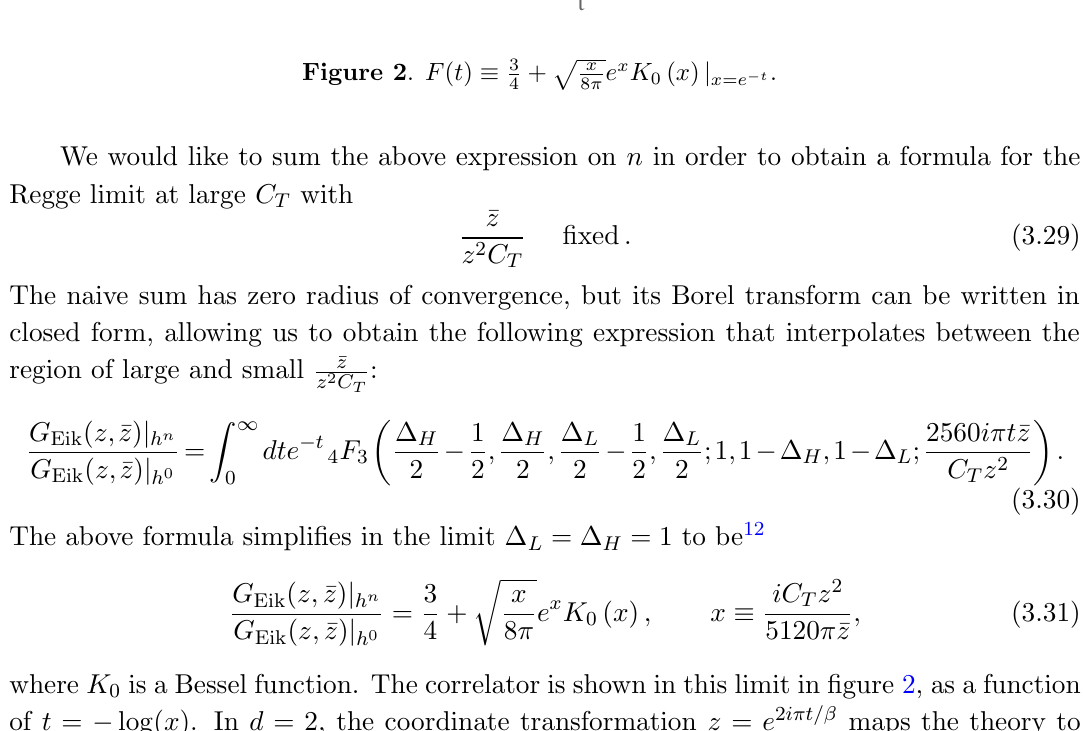
Figure 2 . F ( t ) (cid:17) 3